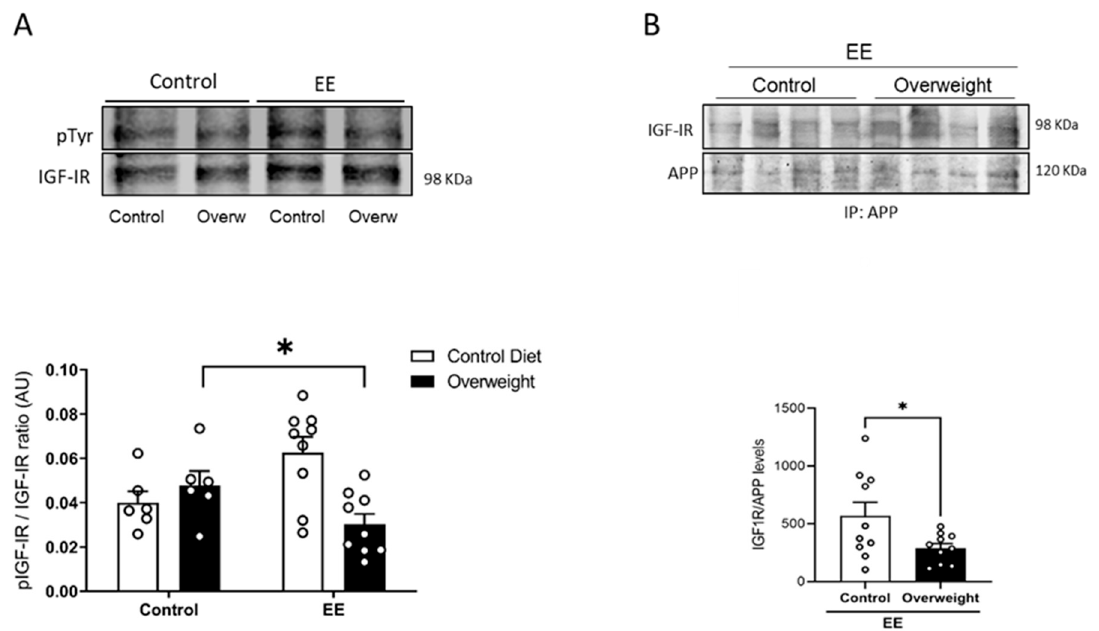
Figure 5. Reduced entrance of serum IGF-I in overweight mice. ( A ) In response to environmental enrichment (EE), overweight mice show lower brain IGF-IR phosphorylation than lean mice receiving a standard diet ( n = 10 EE/6 Control, for each diet). ( B ) Interaction of APP with IGF-IR in the brain of mice submitted to EE stimulation was significantly decreased in overweight mice ( n = 10 per group). Representative blots are shown, together with quantification histograms. * p < 0.05.